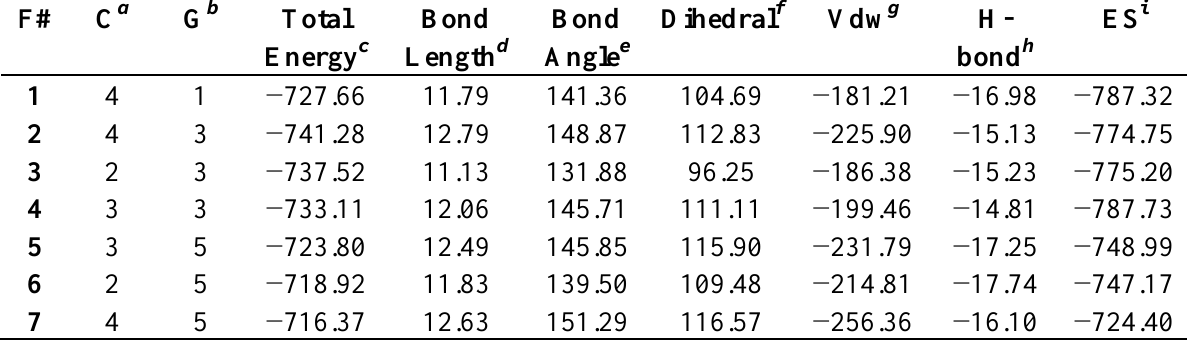
Table 8. Randomized Face-Centered Central Composite Experimental Design